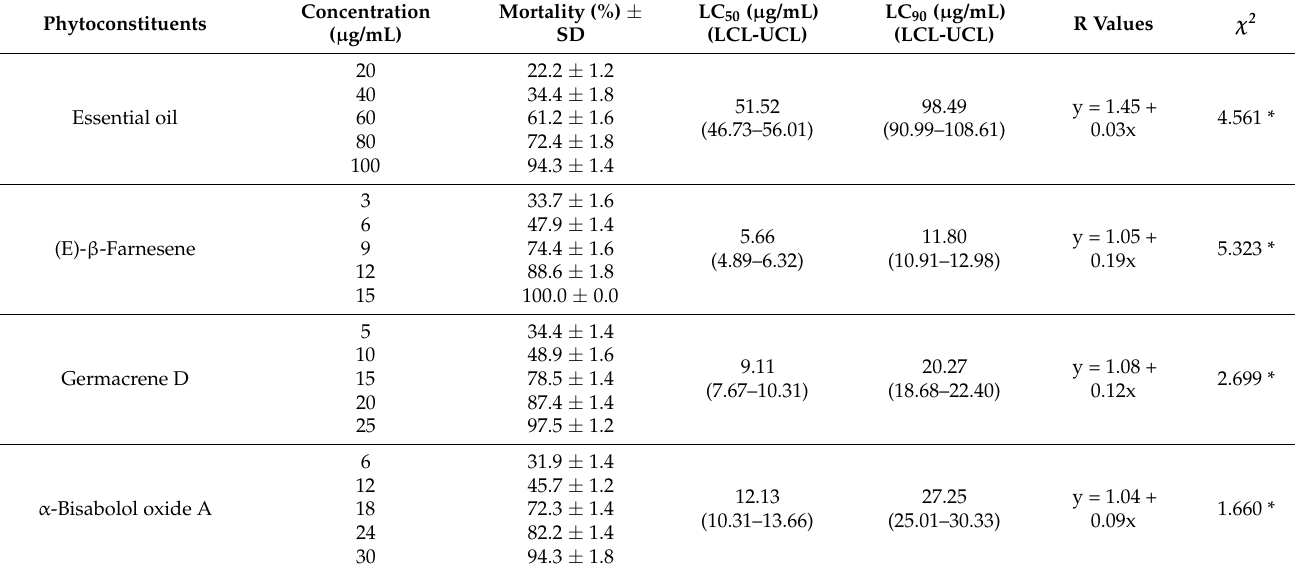
Table 4. Larvicidal activity of Matricaria chamomilla essential oil and its major phytoconstituents against 3rd-instar larvae of Aedes vittatus .